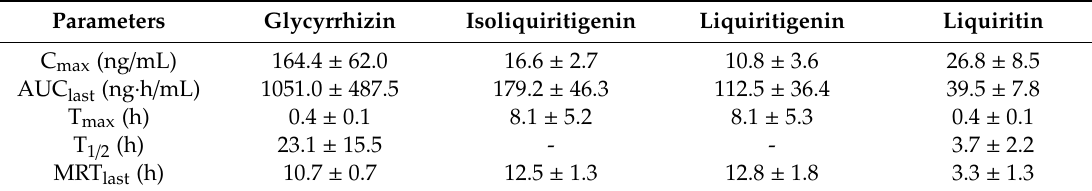
Figure 5. Plasma concentration – time profiles of glycyrrhizin, isoliquiritigenin, liquiritigenin, and liquiritin and after oral administration of GRE to rats. Data were expressed as mean ± SD from four rats per group. Table 7. Pharmacokinetic parameters of glycyrrhizin, isoliquiritigenin, liquiritin, liquiritigenin after oral administration of GRE (1 g / kg) to